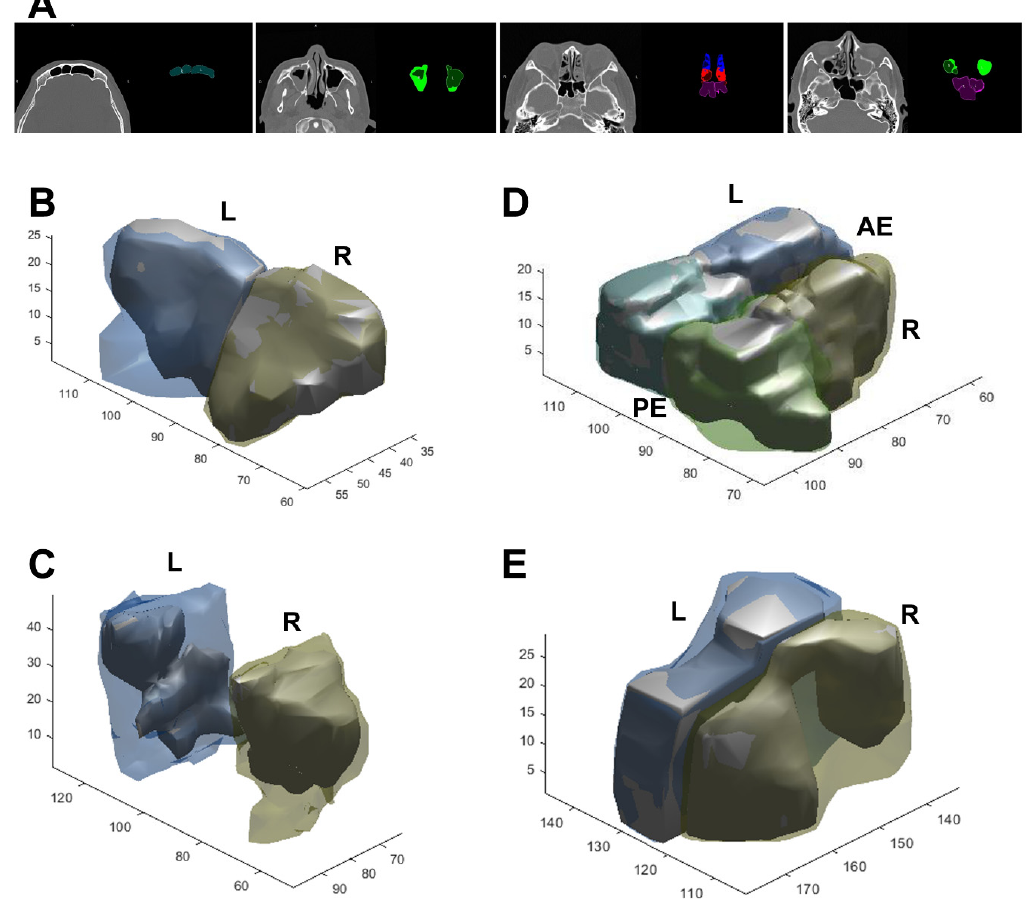
Figure 4. Examples of segmentation ( A ) and 3D reconstruction in CRS patients with air (inner solid part) and opacification (outer hallow part). ( B ) Frontal, ( C ) maxillary, ( D ) anterior and posterior ethmoid, and ( E ) sphenoid sinus. R/L: right/left side, AE/PE: anterior/posterior ethmoid sinus. Table 5. Opacification scores based on the TLMs and VMLMs stratified by surgical intervention. TLMs: traditional Lund-Mackay score; VMLMs: volume-based modified Lund-Mackay score. Max: maxillary sinus, AE/PE: anterior/posterior ethmoid sinus, Fro: frontal sinus, Sph: sphenoid sinus; OMC: ostiomeatal complex.